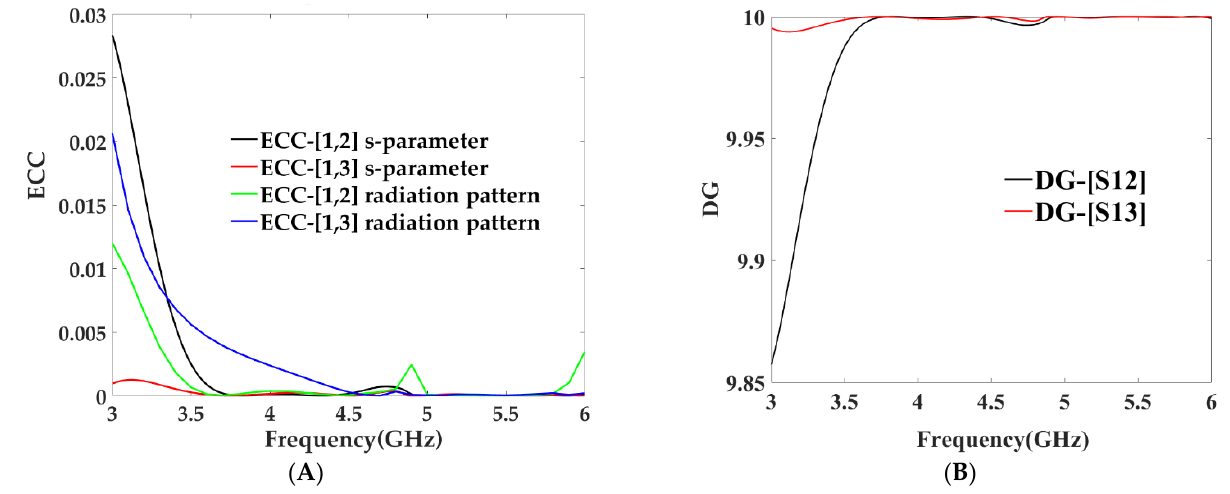
Figure 12. ( A ) Envelope correlation coefficient [dB] vs. frequency [GHz] ( B ) diversity gain [dB] vs. frequency [GHz]. Table 2. Comparison between the proposed antenna and other antenna designs in the literature.